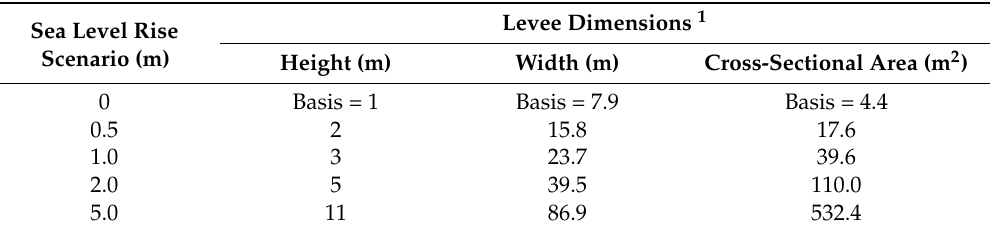
Table 3. Implications for levee design under different sea level rise scenarios.